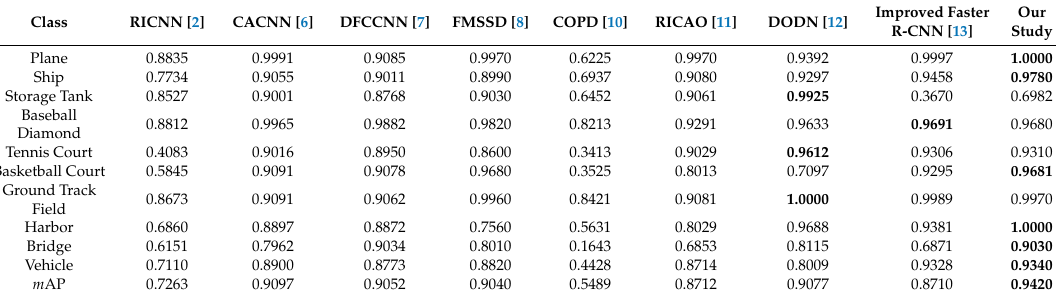
Table 3. Success of diverse models on the NWPU-VHR10